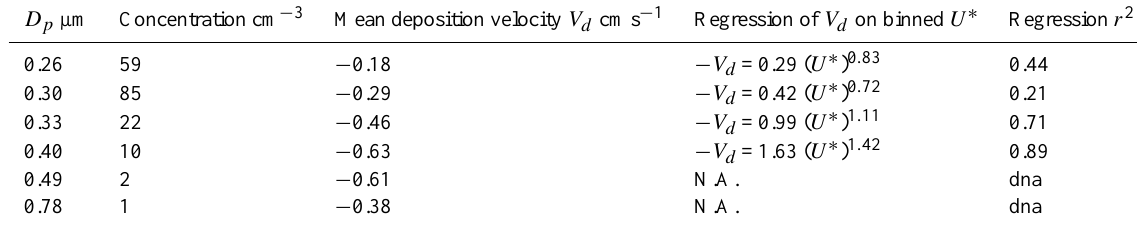
Table 2. Mean daytime (10a.m.–3p.m.) aerosol properties during BEARPEX 2007.